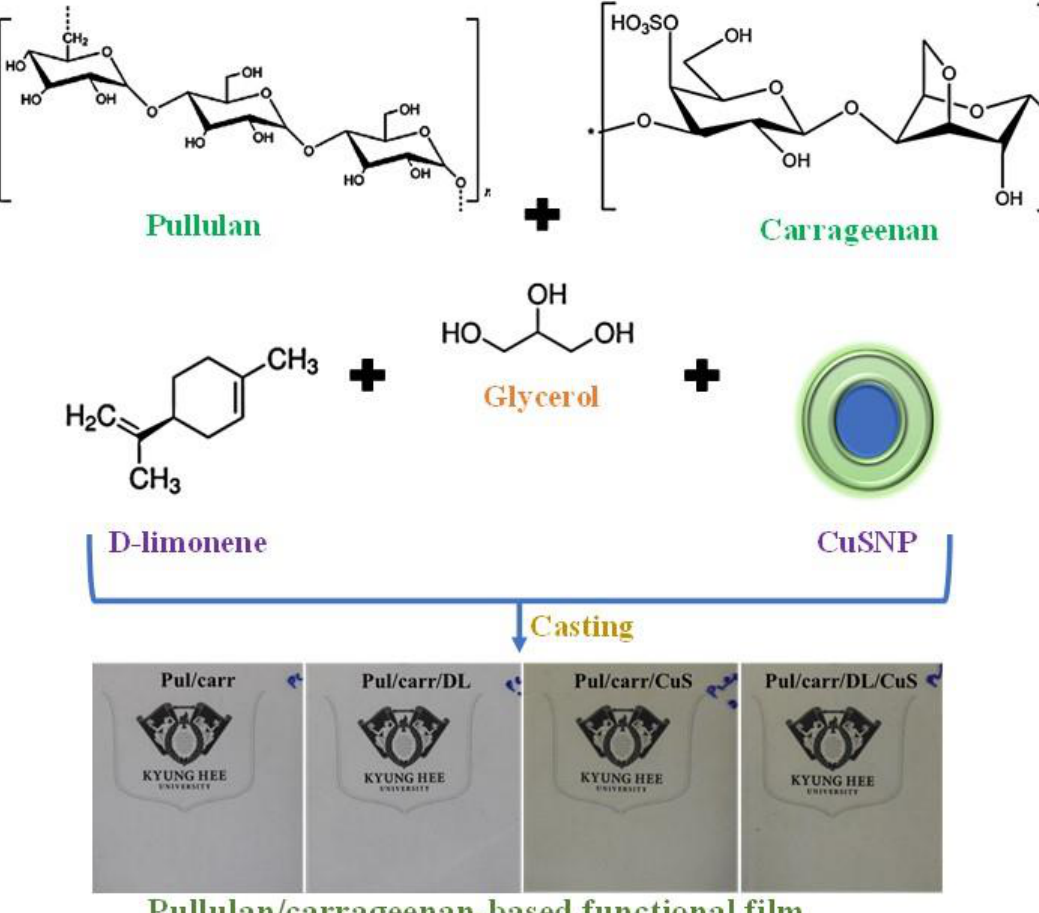
Scheme 1. Schematic presentation for the preparation of Pul/Carr-based films.